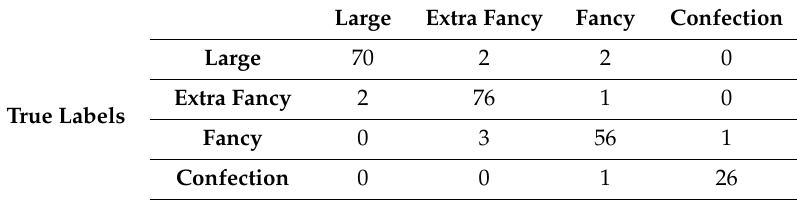
Table 2. Confusion matrix of the Medjool date dataset.